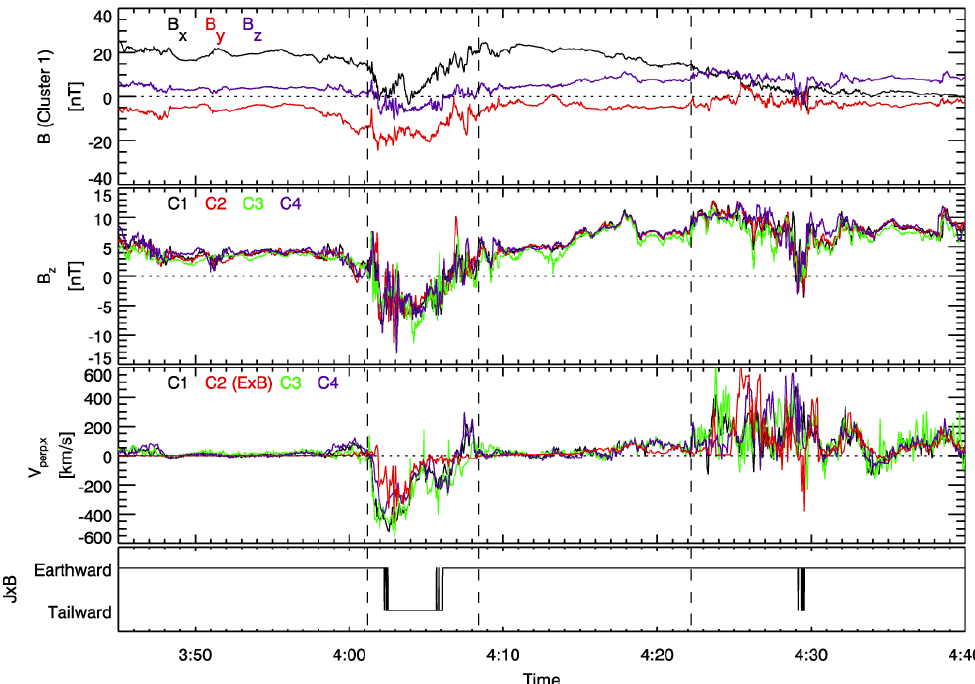
Figure 1. (a) Magnetic field measured at Cluster 1 in event-specific coordinates. (b) z-component (event-specific coordinates) of the magnetic field at all 4 satellites. (c) Velocities perpendicular to the magnetic field. Since data are not available from the ion spectrometer on Cluster 2, the red line shows instead the E × B velocity from the electric and magnetic field instruments. For the other satellites, the E × B velocities agree well with the perpendicular velocities shown. (d) Sense of the J × B vector (Earthward/tailward).